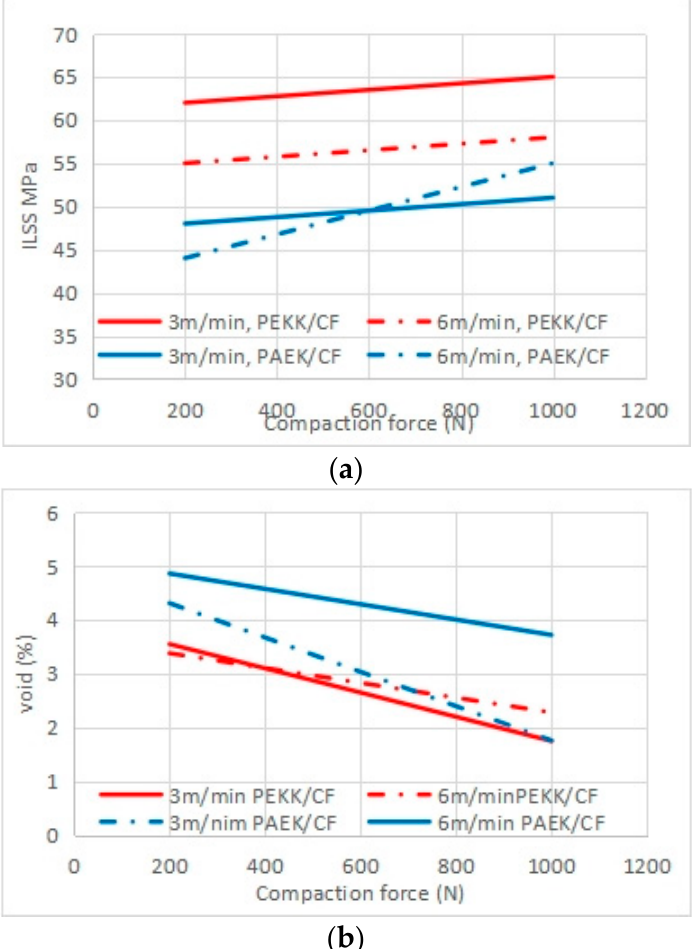
Figure 8. Influence of compact force on ( a ) mechanical properties of ILSS and ( b ) voids of different matrices and speeds.